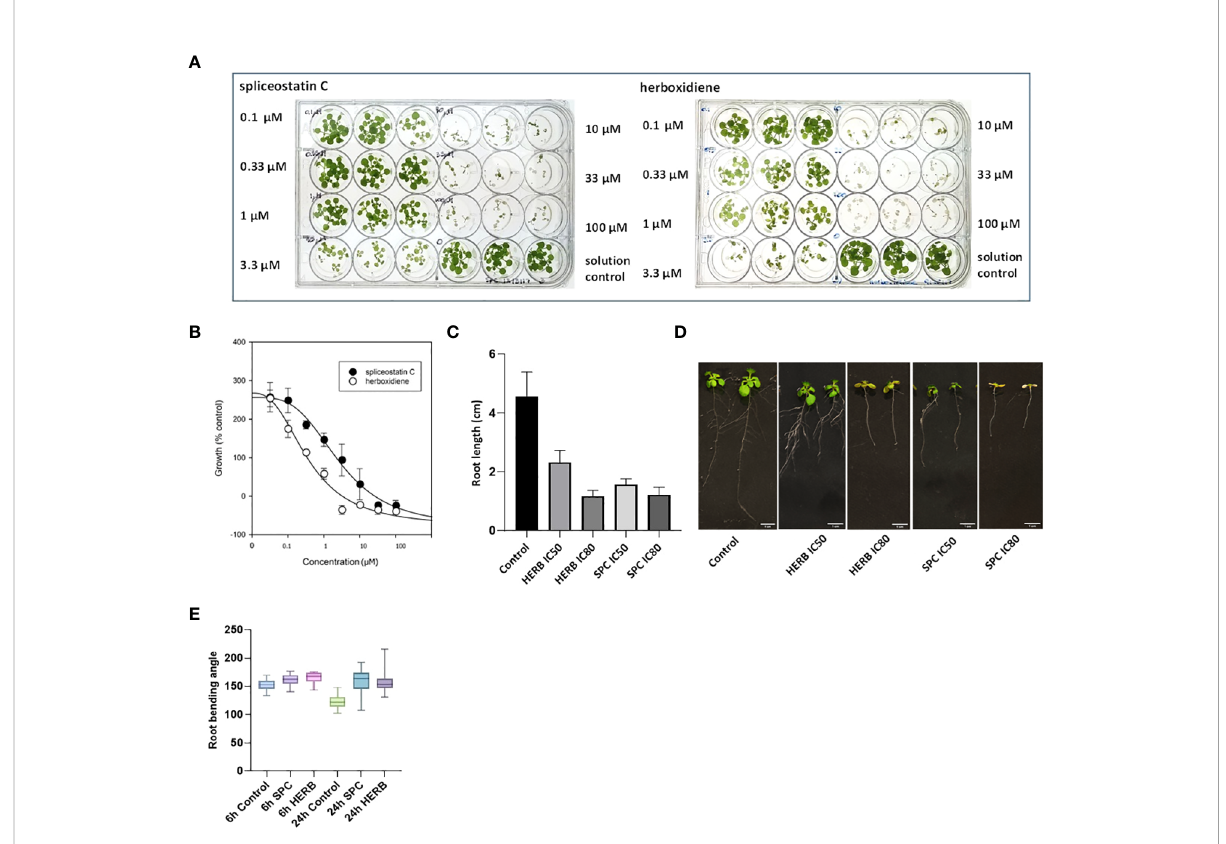
FIGURE 2 Dose-response of Arabidopsis seedlings treated with splicing inhibitors. Representative results are shown for spliceostatin C and herboxidiene seven days post-treatment (A) . Determination of IC 50 and IC 80 values. Data were collected 7 days after treatment of Arabidopsis seedlings. Data are shown as mean ± SD, (n=3) (B) . Growth inhibition of Arabidopsis seedlings by splicing inhibitors. Inhibition of root growth by SPC and HERB at concentrations of IC 50 and IC 80 (C) . Growth of Arabidopsis seedlings 7 days after treatment. Data are shown as mean ± SD, (n=20) (D) . Arabidopsis root gravitropism in response to the splicing inhibitors. See to SPC and HERB at the concentrations of IC 50 . Boxplot represents the distribution of root bending angles of curvature (n=20). Whiskers mark the minimum and maximum values (E)